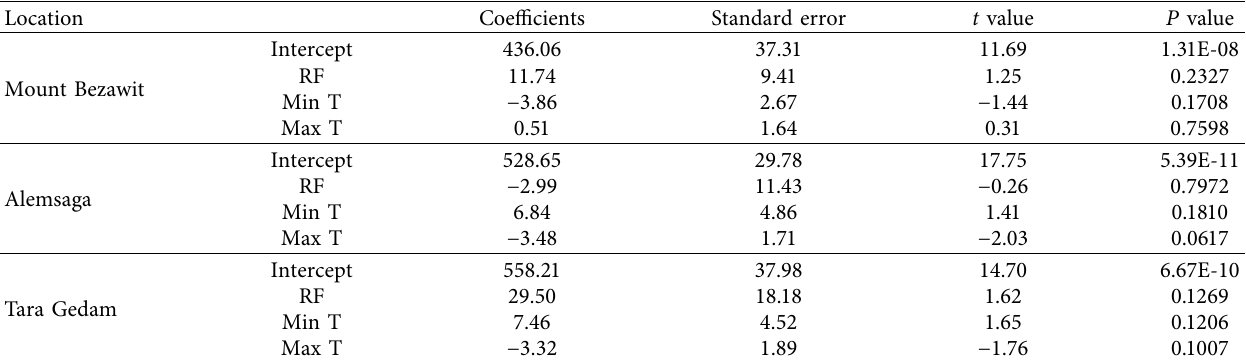
Table 7: Multiple regression analysis between butterfly abundance and weather variables.